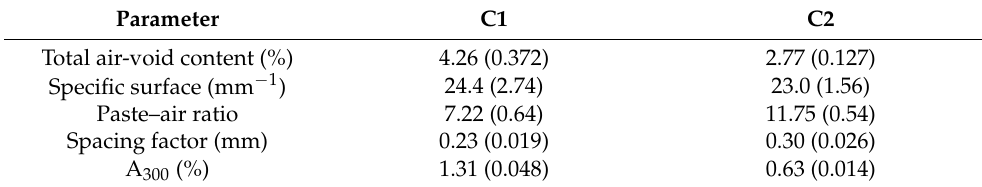
Table 2. Air-void system of hardened concretes: average value (standard